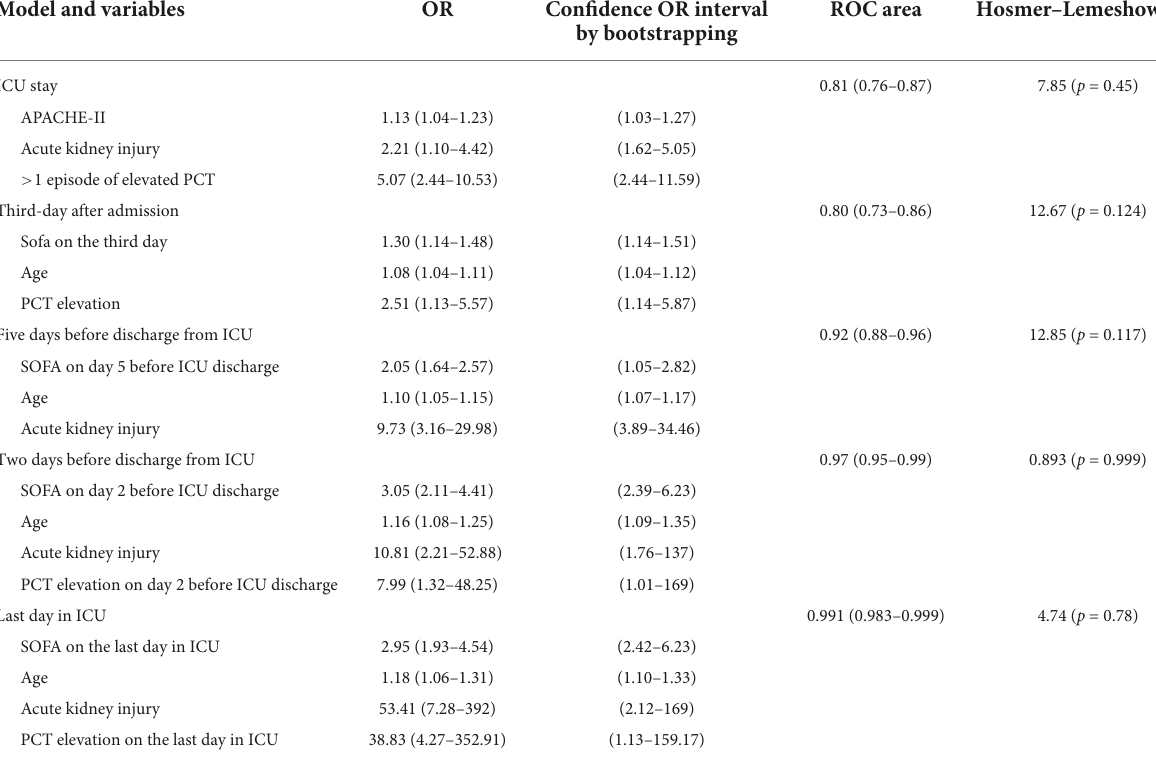
TABLE 3 Multivariate logistic regression models at different times of ICU